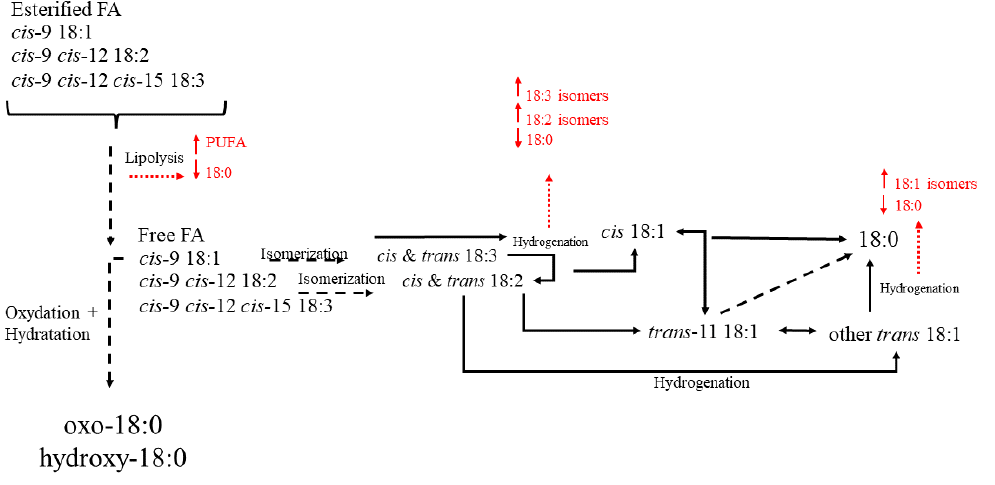
Figure 7. Main biohydrogenation processes in the rumen .